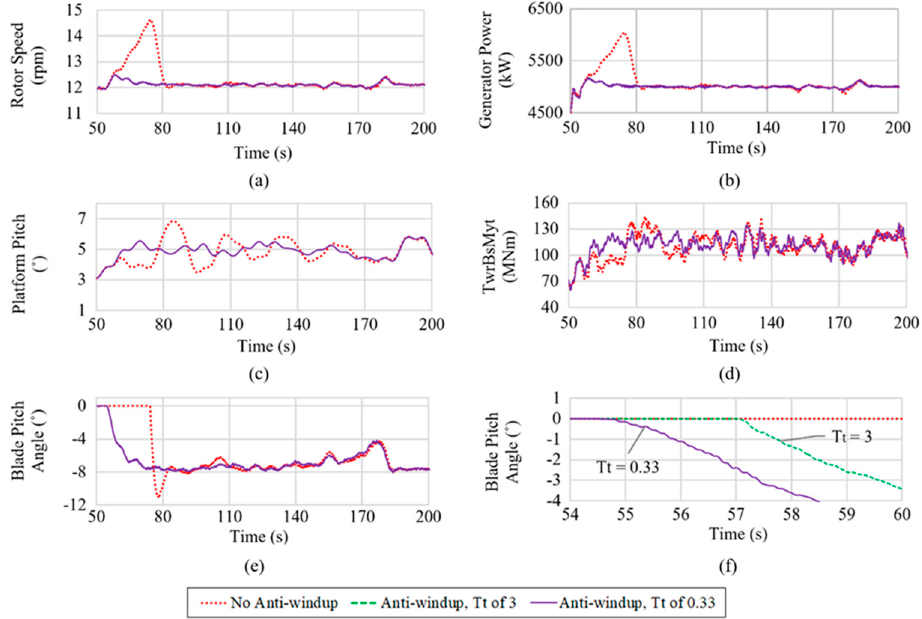
Figure 5. Simulated responses of the “Pitch-to-Stall Model” with and without anti-windup at 13 m/s mean turbulent winds. ( a ) rotor speed (rpm); ( b ) generator power (kW); ( c ) platform pitch ( ◦ ); ( d ) tower base fore-aft bending moment (TwrBsMyt) (MNm); ( e ) blade pitch angle ( ◦ ); ( f ) blade pitch angle ( ◦ ).